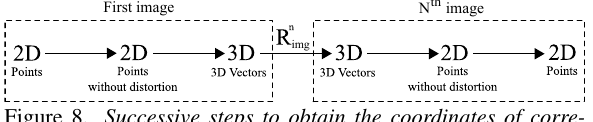
is the estimated img